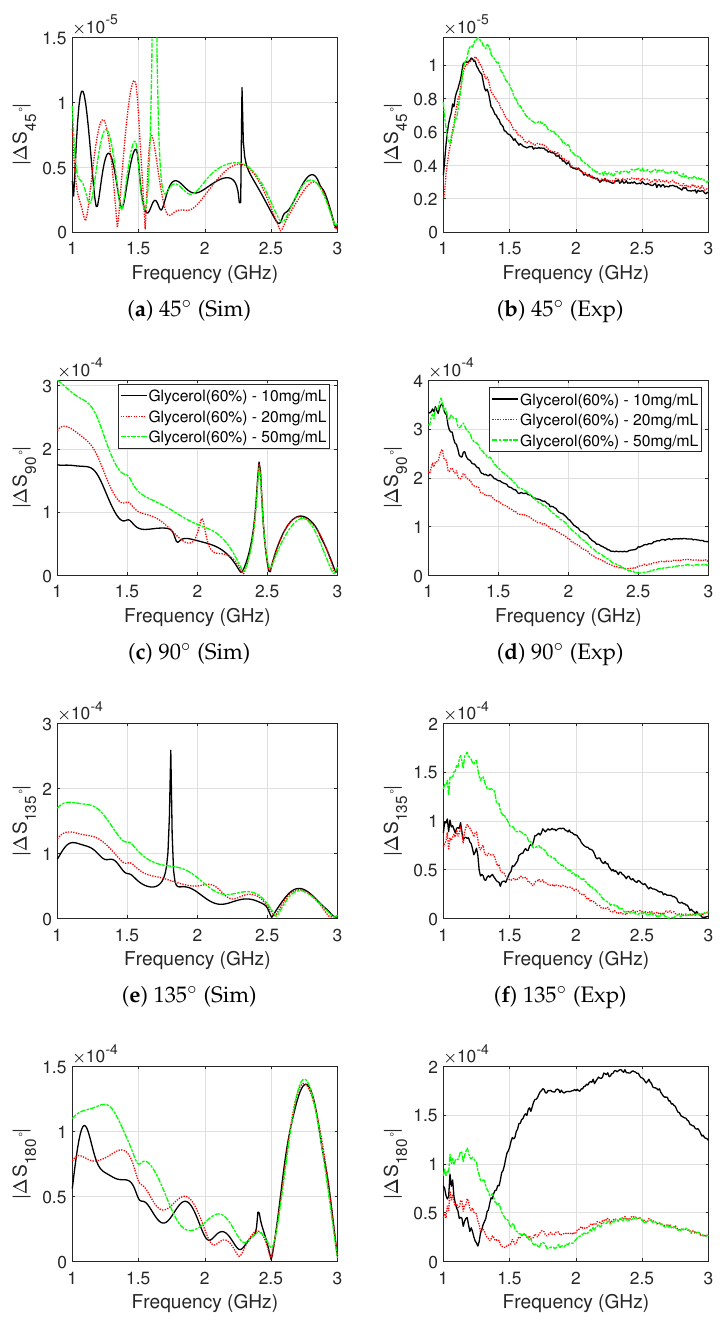
Figure 4. Difference in received signal strength between “no-target” and “target T1” cases, plotted for each receiver position against frequency. T1 is filled with salt concentrations between 10 and 50mg/mL dissolved in 60% glycerol. The simulated ( left ) and experimental ( right ) signal differences are plotted between 1.0 and 3.0 GHz, which is the operational frequency range for the employed